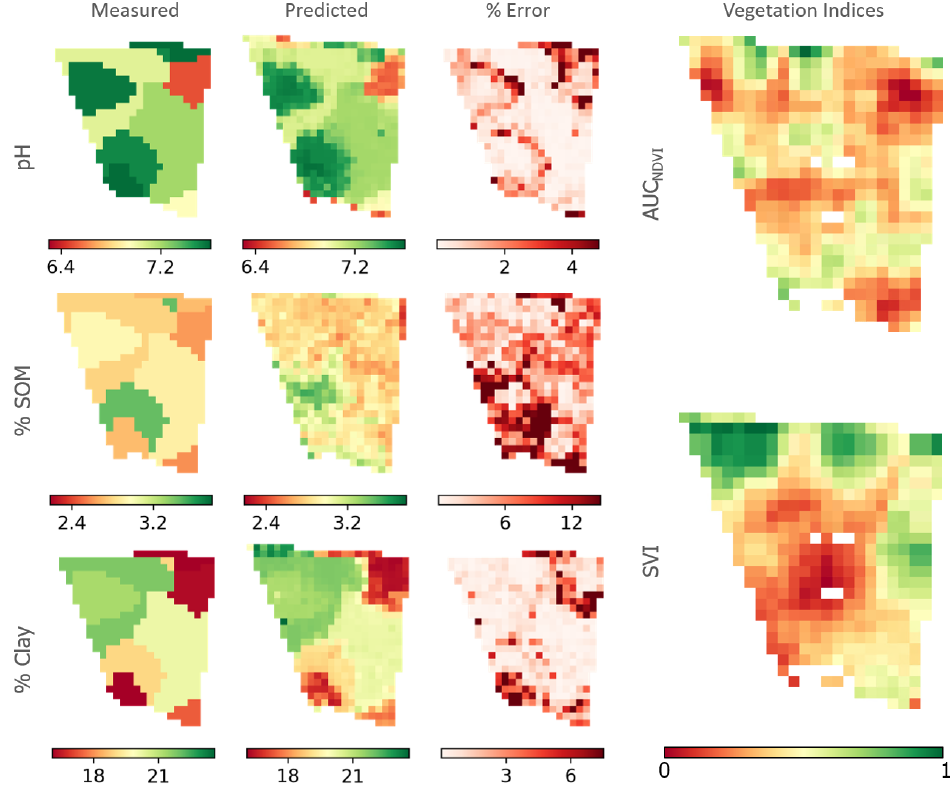
Figure 11. Predicted pH, SOM, and clay content and for the Hasler field located in Switzerland. The columns represents zone averaged ground measurement, pixel level model prediction and percent error, respectively. Also, area under the curve for normalized difference vegetative index (NDVI) and SAR Vegetation Index (SVI) are given for the cultivation period